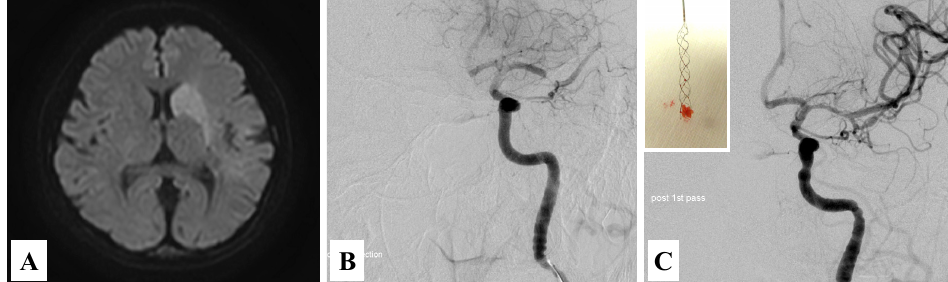
Figure 1. Images of cerebral occlusion and endovascular thrombectomy in this patient with neuro- logical symptoms when visiting to our hospital. The brain MRI showed a high-signal-intensity change in her left brain ( A ). Angiography indicated the occlusion of the left M1 portion before the endovascular thrombectomy ( B ). After the thrombectomy, almost complete recanalization was con- firmed ( C ). Inset in Figure C showed the arterial occlusive thrombus.